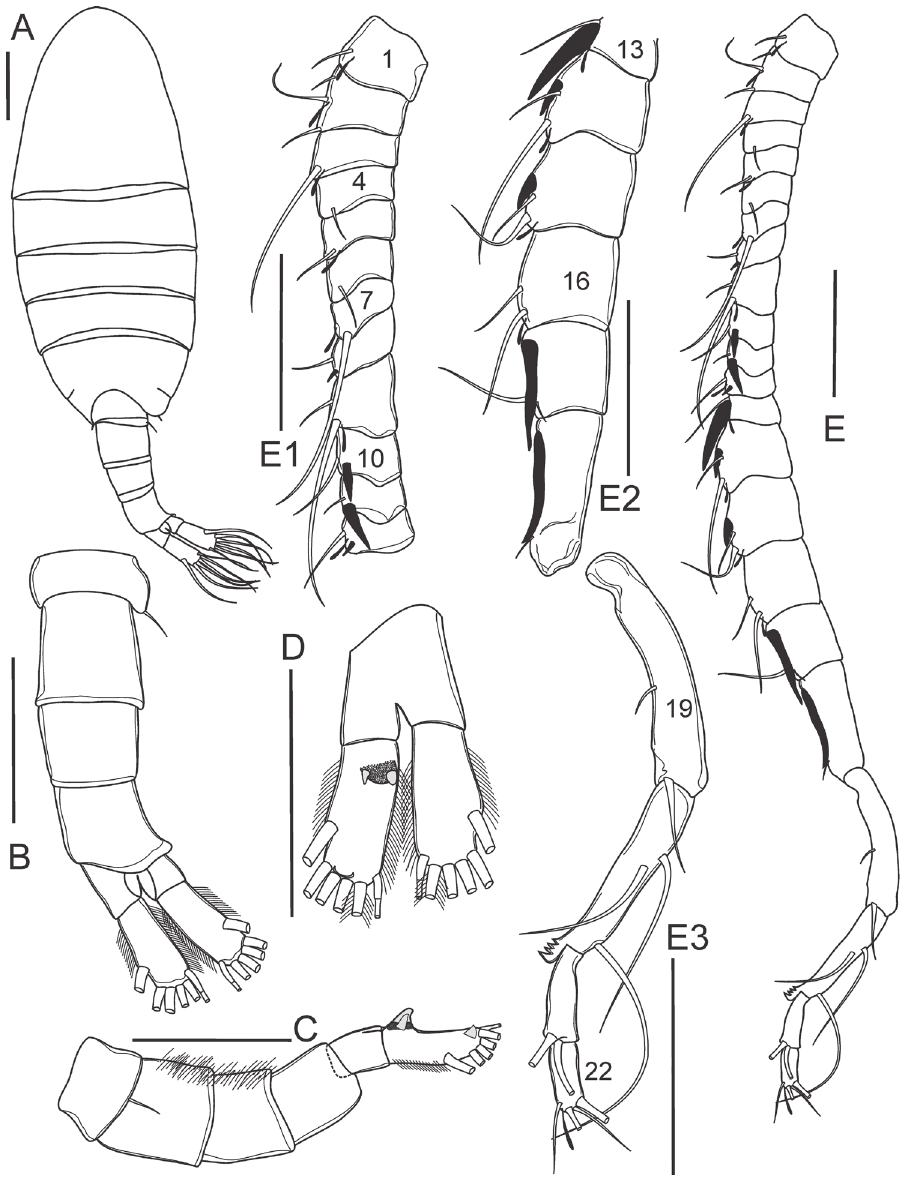
Figure 6. Mongolodiaptomus loeiensis sp. n. Male: A habitus, dorsal view B urosome, dorsal view C urosome, lateral view D anal somite and caudal rami, ventral view E antennule E1 segments 1–12 E2 segments 13–18 E3 segments 19–22. Scale bar 100